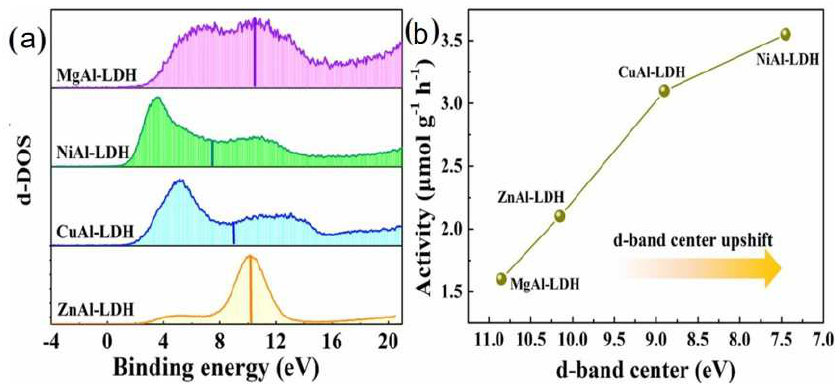
Figure 7. ( a ) Position of d − band center of the different LDHs. ( b ) Relationship of activity and the d − band center position for LDHs [89]. Copyright 2021 Elsevier.